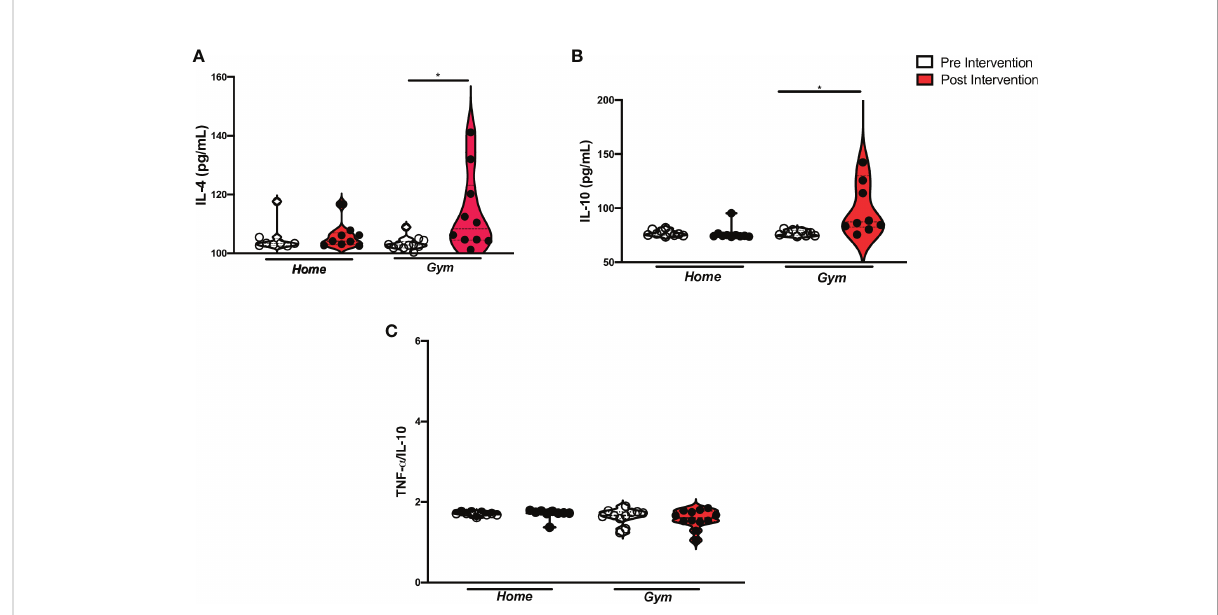
FIGURE 4 Anti-in fl ammatory cytokine levels in Supervised and home-based unsupervised exercise on recovered COVID-19 patients. ANOVA between Supervised and home-based unsupervised exercise on the anti-in fl ammatory cytokines and TNF- a /IL-10 ratio from baseline to 12 weeks of intervention (Pre- and Post-intervention). Home, the home-based unsupervised exercise group; Gym, supervised exercise group; Serum levels; (A) IL-4, Interleukin-4 (home (pre), n= 8, home (post), n= 12; gym (pre), n= 9, gym (post), n=11; p = 0.006); (B) IL-10: Interleukin-10 (home (pre), n= 10, home (post), n= 10; gym (pre), n= 10, gym (post), n=11; p = 0.04); (C) TNF- a /IL-10 ratio: (home (pre), n= 9, home (post), n= 9; gym (pre), n= 12, gym (post), n= 13; p = n.s.); pg/mL, picogram per milliliter; *p<